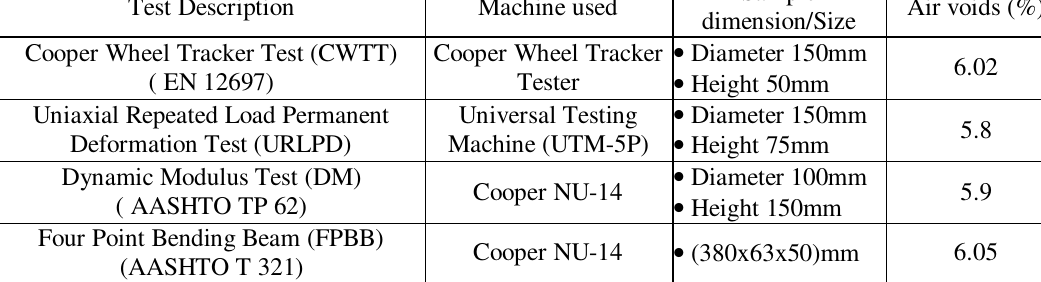
Fig. 5(b): Sample for URLPD test Fig. 5(c): Sample for FPBB test Table 6: Test description and specimen